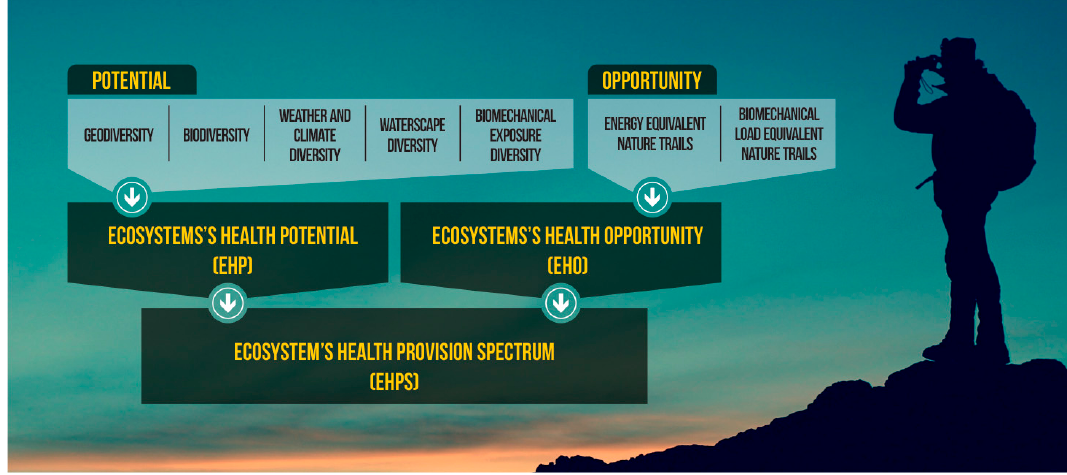
Figure 2. A methodological framework to ecosystems’ health provision spectrum for geoparks.